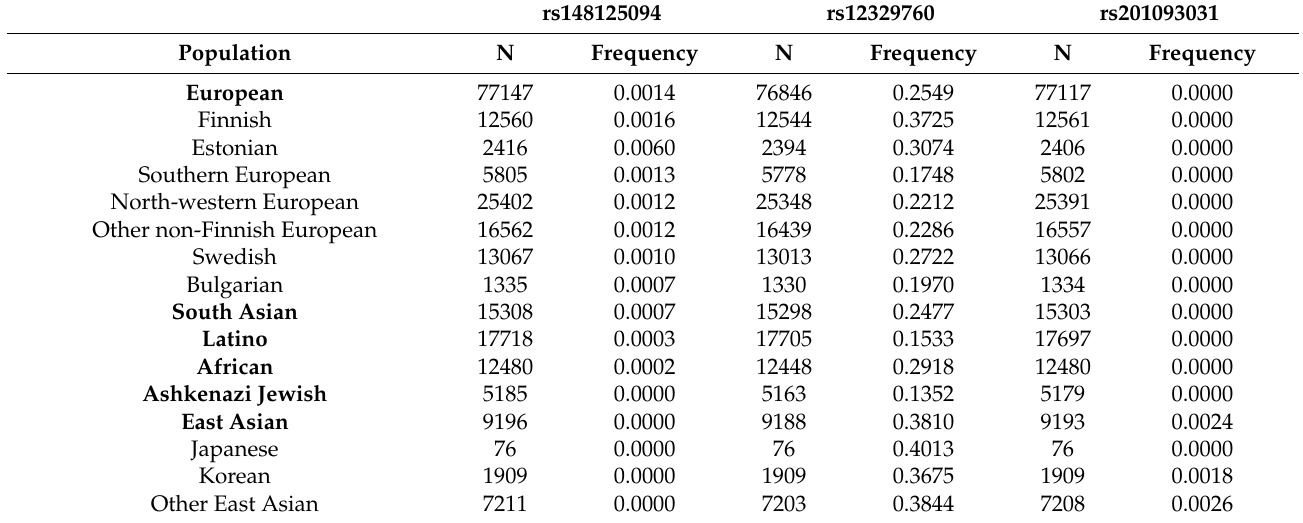
Table 4. Frequency of TMPRSS2 missense mutations in worldwide data (GnomAD). AZ General information about the region from individual populations was highlighted in